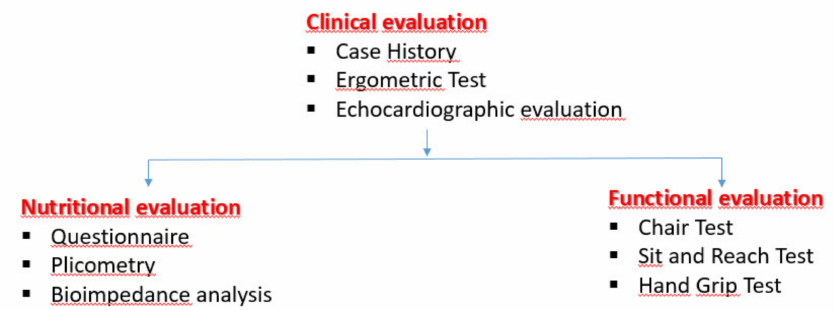
Figure 1. The first step was the clinical evaluation to evaluate the clinical stability and therefore the potential inclusion criteria. Parallelly, nutritional and functional investigations were carried